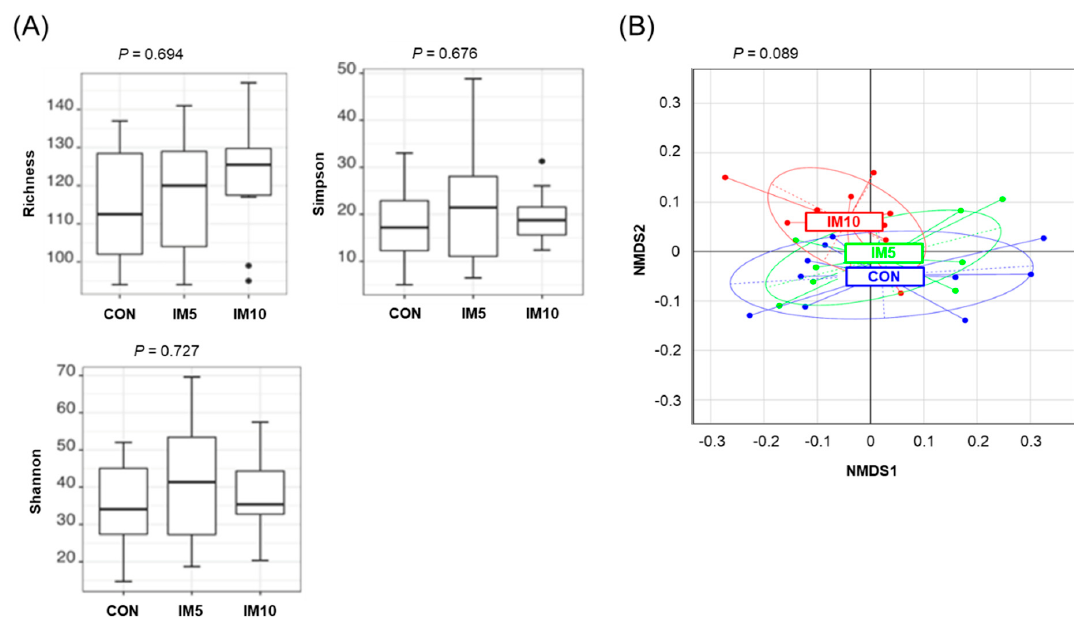
Figure 2. Effect of dietary treatment on cecal microbiota diversity in pigs fed isonitrogenous diets without (CON) or with 5% (IM5) or 10% Tenebrio molitor larvae meal (IM10) for four weeks. ( A ) Indicators of α -diversity (Richness, Simpson, Shannon) of the cecal bacterial community; ( B ) Visualization of the difference in β -diversity of cecal bacterial community between groups by meta non-metric multidimension distance matrix plot. The β -diversity of the cecal bacterial community was calculated based on generalized UniFrac distances.